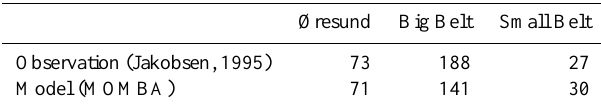
Table 2. Volume transport [km 3 ] through the Danish Straits from 5 to 26 January 1993 to the Baltic. Øresund Big Belt